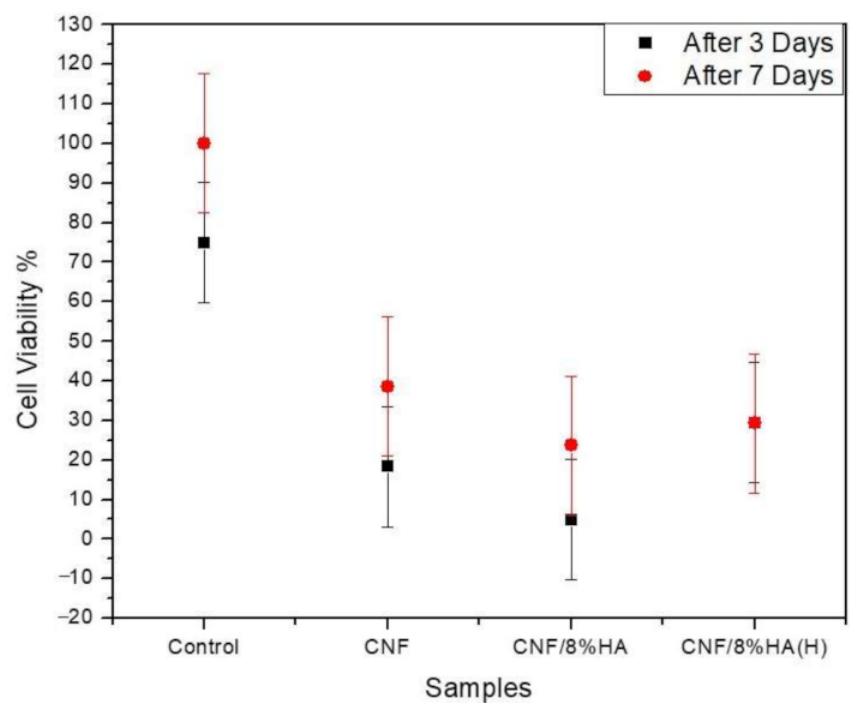
Figure 6. Proliferation of fibroblast cells on the prepared samples (CNF, CNF/8HA, and CNF/8HA (H) in compare with the positive control (without